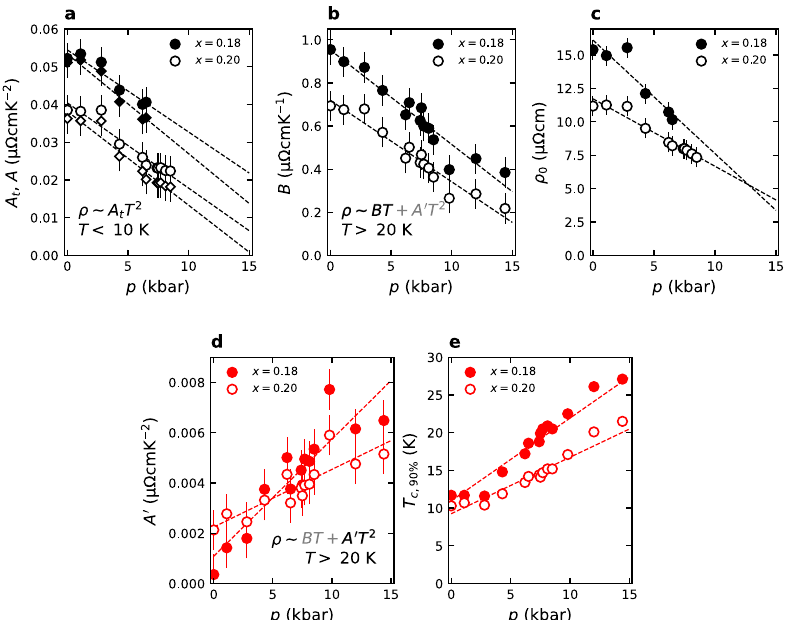
Fig. 2 Pressure dependence of the resistivity coef fi cients and superconductivity. a Pressure p -dependence of the low-temperature T 2 coef fi cient A t (circles) obtained from linear fi ts of the derivative of the resistivity d ρ /d T below 10 K (black lines in Fig. 1c, d). Also shown are the coef fi cients A = A t – A ′ (diamonds), the component of A t attributed to electron – electron scattering dressed by critical nematic fl uctuations. Dashed lines are linear fi ts to the data. The strengthening superconductivity prevents A t (and A ) from being determined at the highest applied pressures. b Pressure dependence of the T -linear coef fi cient B was obtained by fi tting d ρ /d T measured between 20 and 40 K to a straight line. Dashed lines are linear fi ts to the data. c Pressure dependence of the residual resistivity ρ 0 was obtained by extrapolating the low- T ρ ( T ) curves at 35 T to 0 K. Values were only obtained up to the pressures at which superconducting fl uctuations do not in fl uence ρ ( T ). The dashed lines are extrapolations of straight-line fi ts to the data points. d Pressure dependence of the high- T T 2 coef fi cient A ′ as obtained from straight-line fi ts to d ρ / d T at 35 T and above 20 K. e Pressure dependence of the superconducting transition temperature T c de fi ned as the temperature at which the zero- fi eld resistivity reaches 90% of its value at 35 T. T c in both samples exhibits an enhancement by a factor of around two. The error bars in panels a – d are re fl ective of the variation of the obtained coef fi cients to details of the fi tting procedure (principally the precise choice of temperature range being fi tted to). We estimate there to be an additional 30 – 50% systematic error due to uncertainty in sample and contact geometry. The error in the obtained values in panel e are within the size of the data